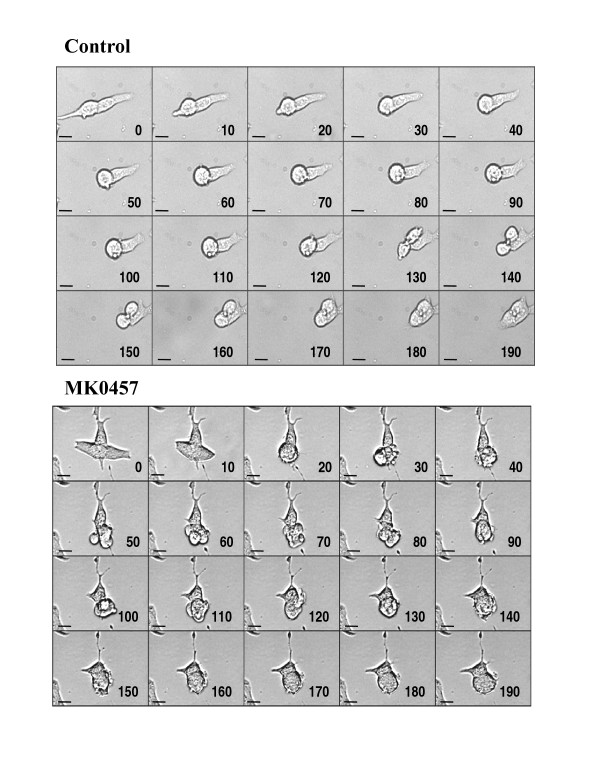
Time-lapse analysis of control and MK-0457 treated TT cells. Pictures of cells cultured in the absence or in the presence of 200 nM MK-0457 were recorded every 5 min during 24 h using the MetaVue software. Data reported are representative of one out of three similar experiments. Numbers in the inserts represent the minutes. Scale bar, 10 μm.